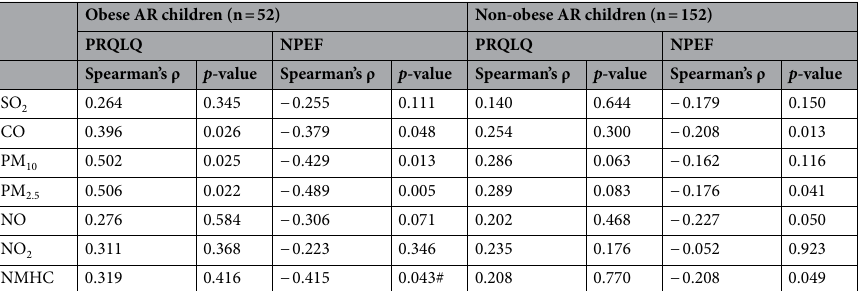
Obese AR children (n =